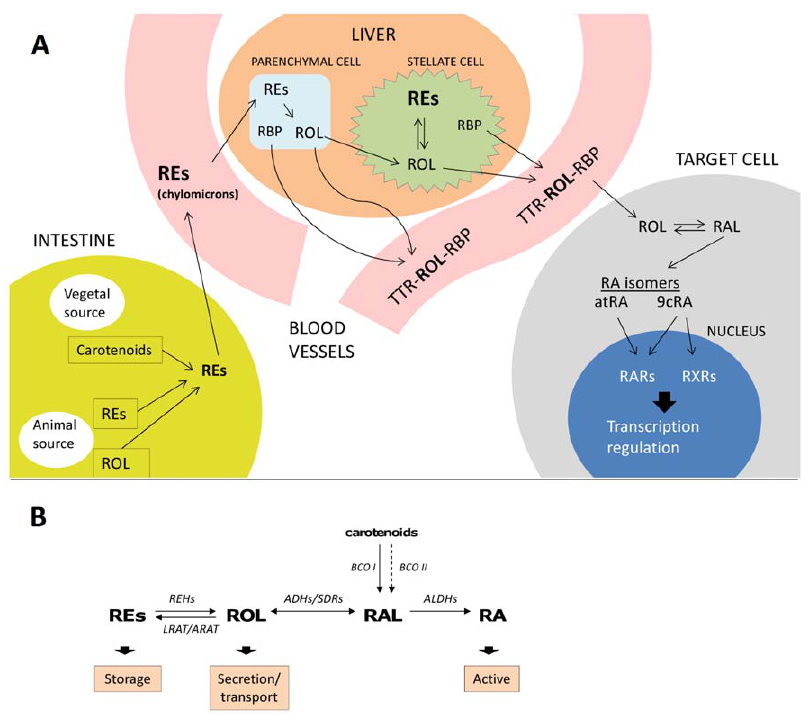
Figure 1. Overview of the retinoid metabolism in vertebrates . A. Major pathways in retinoid metabolism. In the intestine, retinoids and carotenoids taken in the diet (from animal and vegetable sources, respectively) are mainly converted to REs, which are incorporated into chylomicrons and taken to the liver trough the lymph and general circulation. In the liver the REs are taken up by hepatocytes and hydrolyzed to ROL which is bound to RBP for transport to storage or target cells. ROL could be stored as REs in liver stellate cells. When required, the ROL is bound to RBP and mobilized from hepatocytes or stellate cells to circulation, where is bound to TTR to avoid glomerular filtration in the kidney and to ensure delivery to target cells. Once in the target cell, free ROL is oxidized to RAL and then to RA, which enters the nucleus and activates RXRs and/or RARs, regulating gene transcription. For a complete description of retinoid metabolism see references [2] and [3].B: Main biochemical routes involved in the retinoid system. (9cRA), 9- cis -retinoic acid; (ADHs) alcohol dehydrogenases (medium-chain dehydrogenases/reductases family); (ALDHs) aldehyde dehydrogenases; (ARAT) acyl-CoA:retinol acyltransferase; (atRA), all-trans-retinoic acid; (BCO I), % , % -carotene-15,15 9 -monooxygenase; (BCO II), % , % -carotene 9 9 ,10 9 -dioxygenase; (LRAT), lecithin:retinol acyltransferase; (RA), retinoic acid; (RAL), retinaldehyde; (RARs), retinoic acid receptors; (RBP), retinol binding protein; (REHs), retinyl ester hydrolases; (REs), retinyl esters; (ROL), retinol; (RXRs), retinoid X receptors; (SDRs) short-chain dehydrogenases/reductases; (TTR), transthyretin.